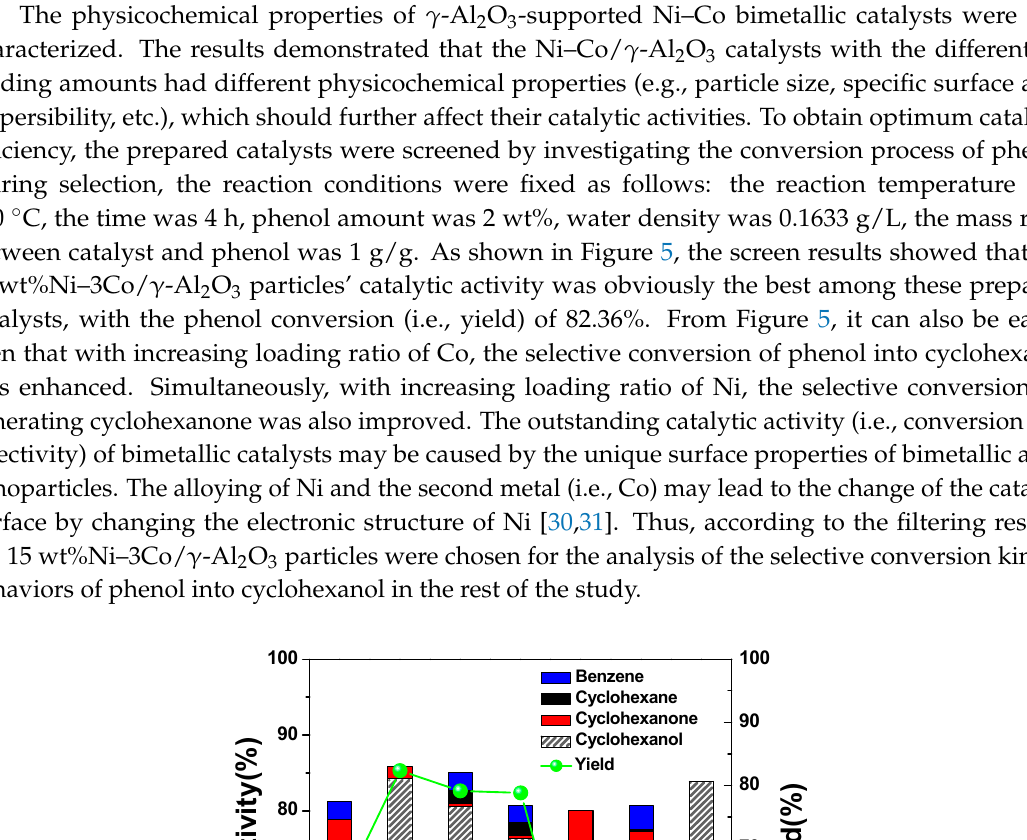
Figure 4. TEM images of ( A , B ) 15 wt%Ni/ γ -Al 2 O 3 , ( C , D ) 15 wt%Ni-3Co/ γ -Al 2 O 3 , and ( E , F ) 15 wt%Co/ γ -Al 2 O 3 .